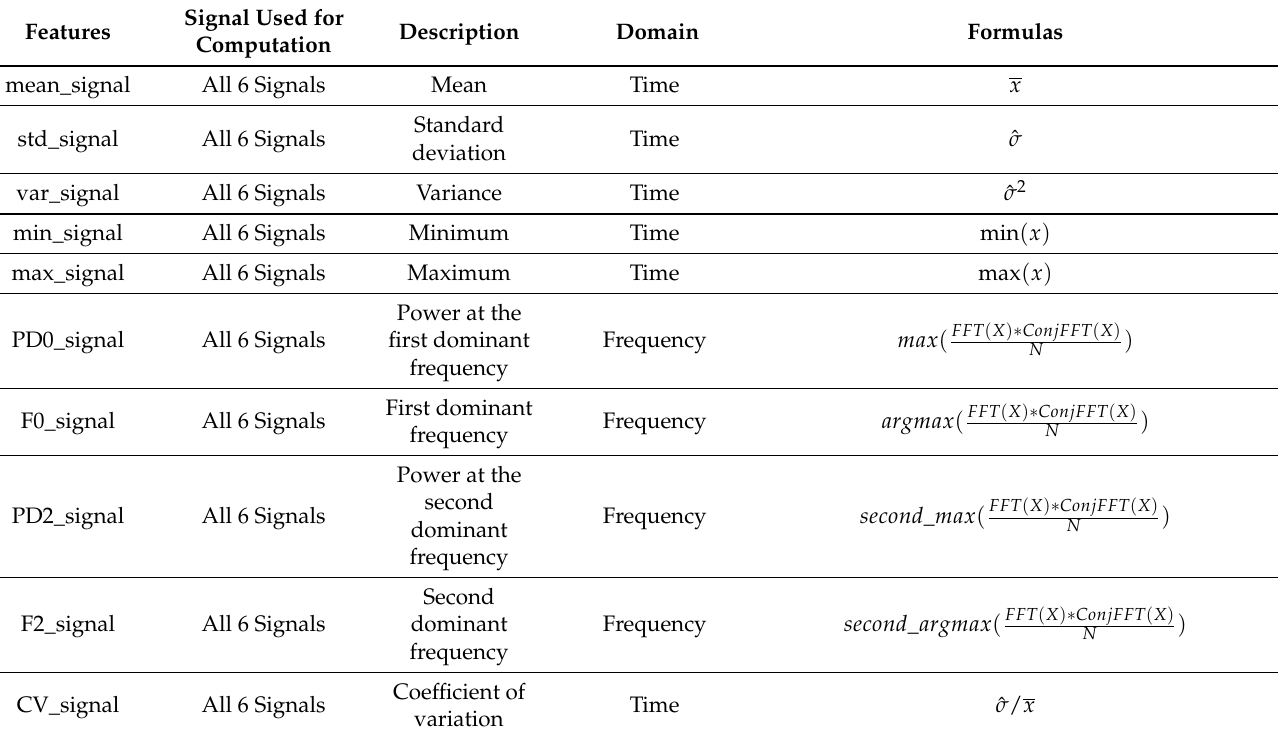
Table 2. Details of features used for classification. For each formula, X = [ x 1 , x 2 . . . , x n ] is assumed to be one of the six dimensions (three linear accelerations and three angular velocities) from the IMU signal. In total, 135 features are used. Notations: x is the empirical mean of X , ˆ σ is the empirical unbiased standard deviation of X , FFT( X ) is the Fourier transform of X, ConjFFT( X ) denotes the complex conjugate of FFT( X